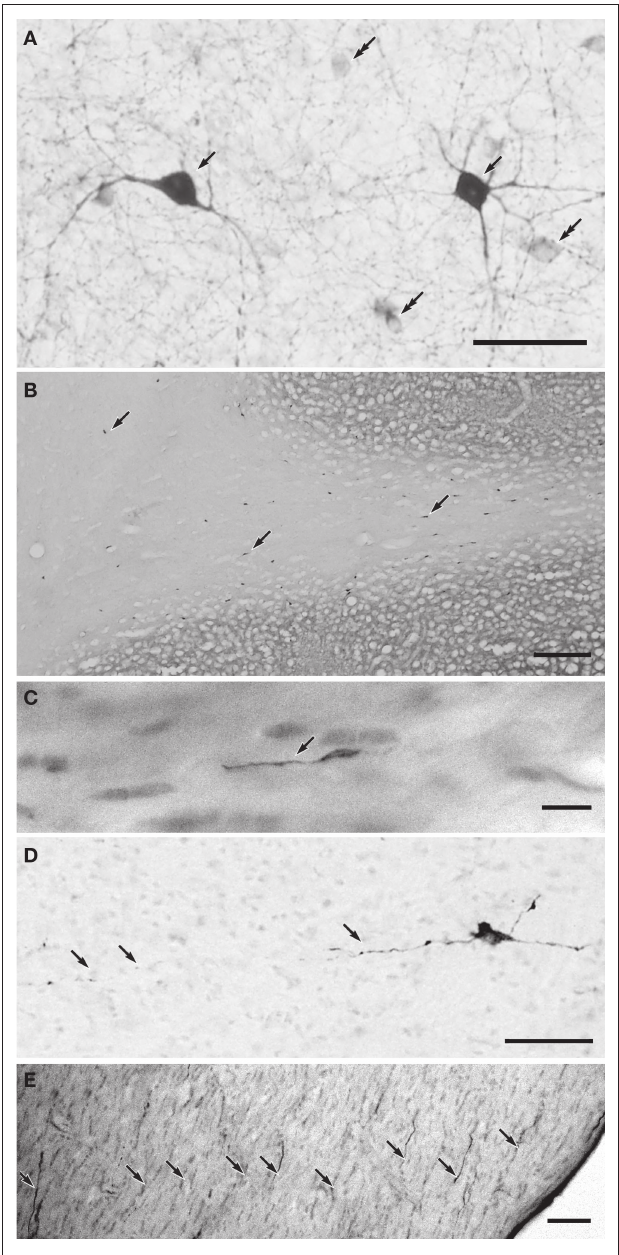
FIGURE 1 | (A) NADPH-d positive GABAergic neurons in the middle suprasylvian gyrus of the cat neocortex. (B) A low magnifi cation photograph of a section with NADPH-d positive neurons in the middle suprasylvian gyrus. (C) A NADPH-d positive axon fi ber fragments in the white matter of the neocortex. (D) An NADPH-d-positive type I cell extending an NADPH-d-positive axon fi ber in the white matter of the neocortex. (E) NADPH-d positive axon fi ber fragments in the fi mbria. Arrows indicate NADPH-d positive type I cells and their axons. Double-arrows in (A) indicate NADPH-d type II cells. Calibration bars in (A–E) are 10 µm, 300 µm, 10 µm, 50 µm, and 50 µm,